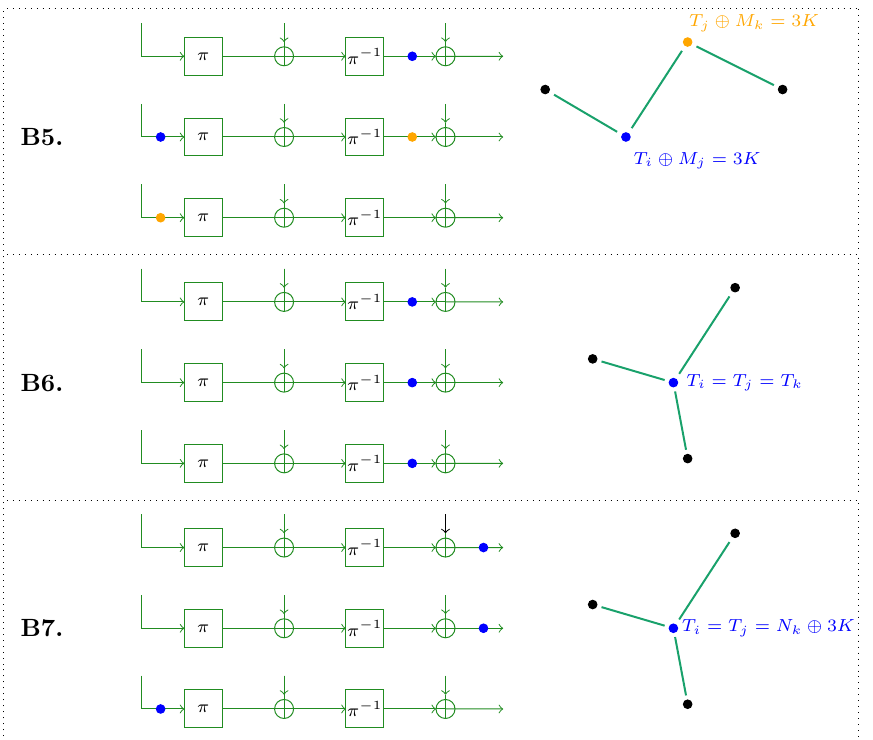
Figure 9: Collisions amongst three authentication queries - Figurative and graphical representa- tions of the bad